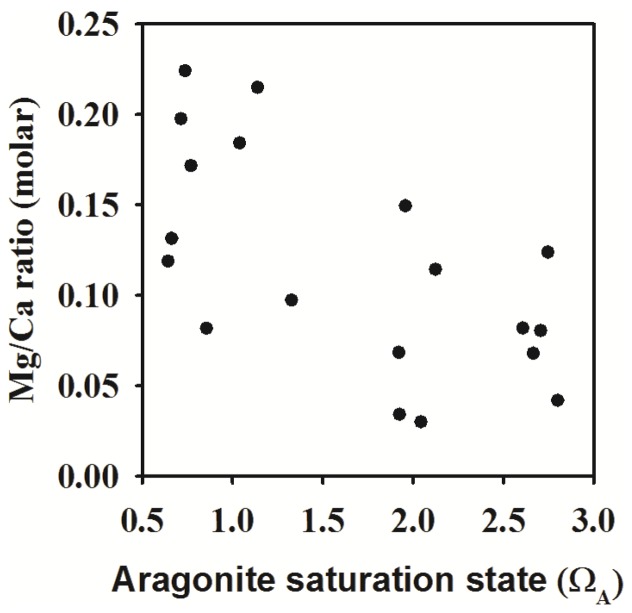
The relationship between aragonite saturation state and the tube magnesium to calcium (Mg/Ca) ratio.The strength of the relationship was analyzed using the Spearman's rank-order correlation coefficient.